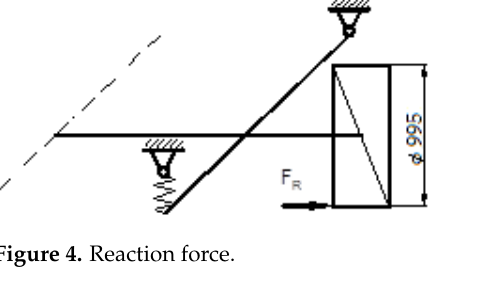
Figure 4. Reaction Figure 4. Reaction force.